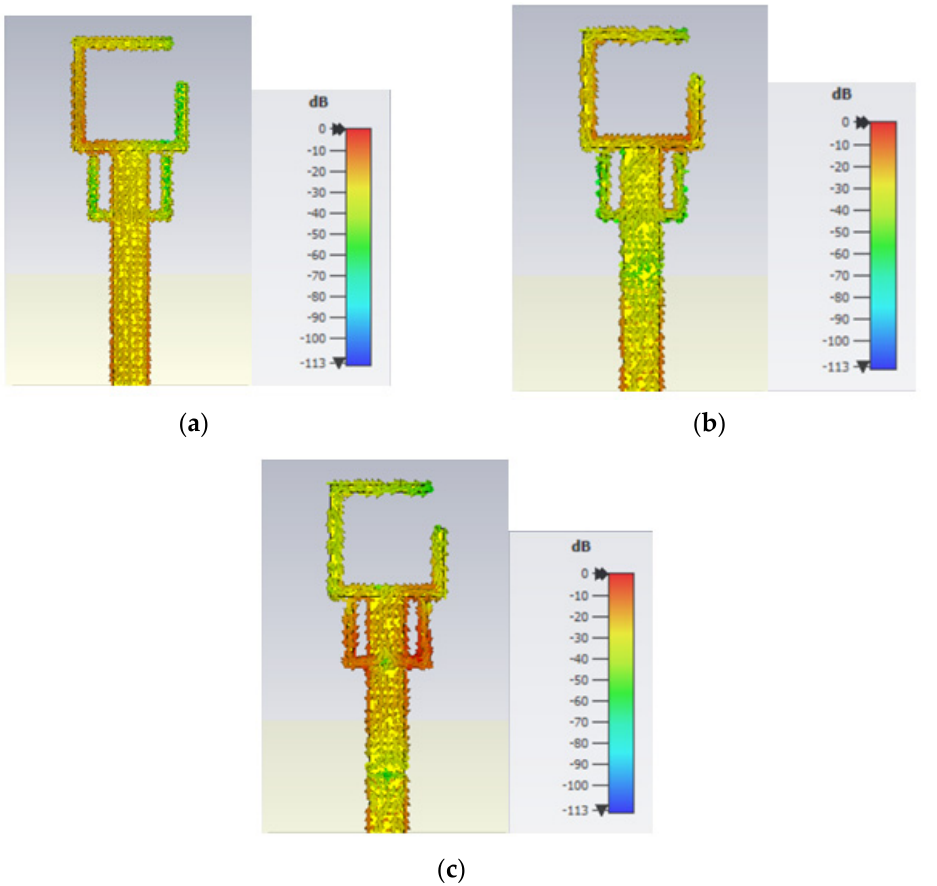
Figure 12. The simulated current distribution of the proposed design at ( a ) 2.4 GHz, ( b ) 3.7 GHz, and ( c ) 5.8 GHz.